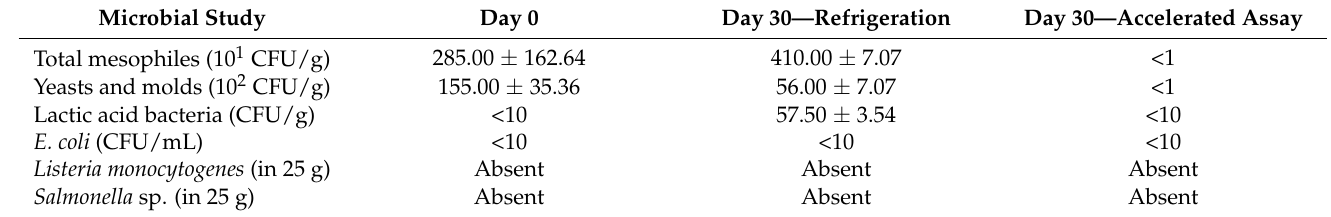
Table 6. Evolution of microbial counts in 7.5% ( w / w ) miso emulsion, from day 0 to day 30, after 30 days under refrigeration or under accelerated assay.